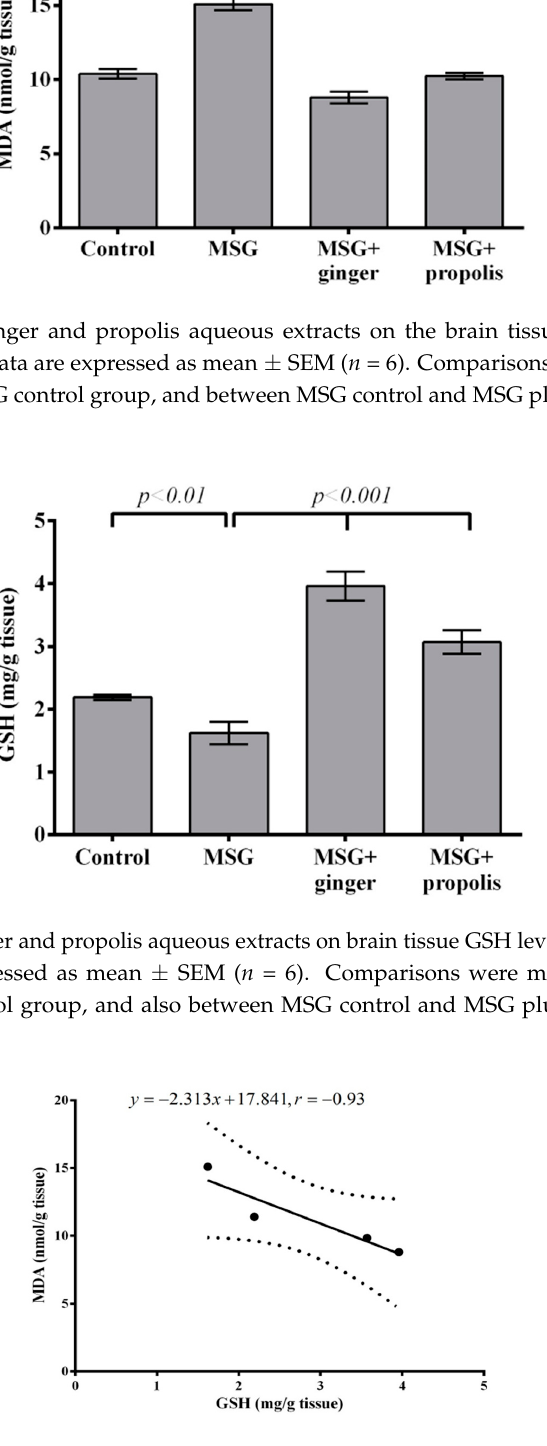
Figure 6. Relationship between brain GSH and MDA levels two months following MSG administration in the experimental groups. The correlation coefficient is − 0.93, i.e., an inverse relationship between the GSH and MDA after two months of MSG administration. The distance between the dotted curves is the correlation area, which involves the data, and the line represents the regression strength indicator, i.e., the closer the data to linear line, the stronger the correlation.